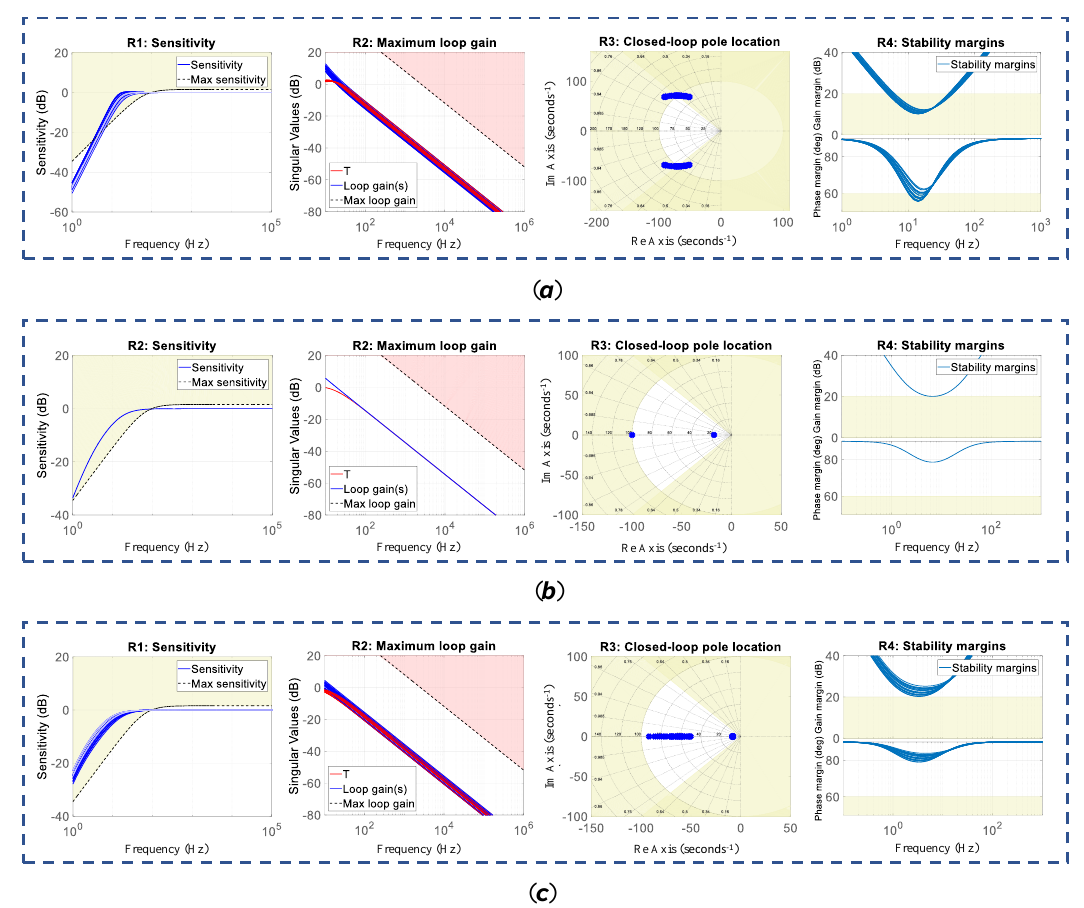
Figure 10. Closed-loop specifications’ verification for the v DC loop: ( a ) PP-PI, ( b ) H ∞ -PI, and ( c ) H ∞